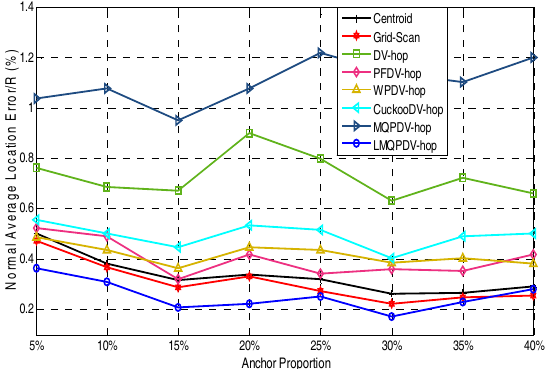
Figure 16. Communication range 300 WSN#2.